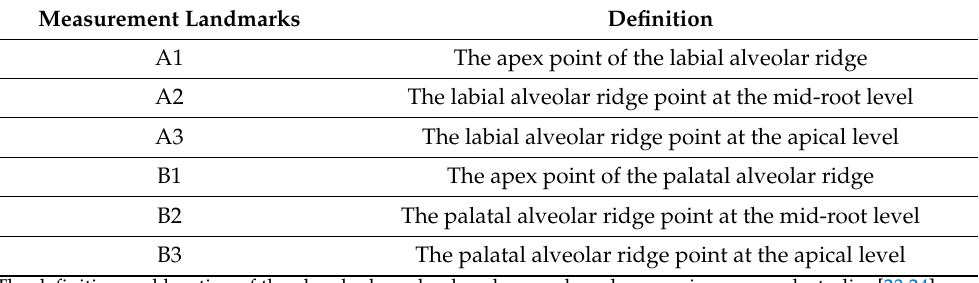
Table 3. Measurement landmarks for evaluating the alveolar bone thickness at crestal, mid-root, and apical levels.